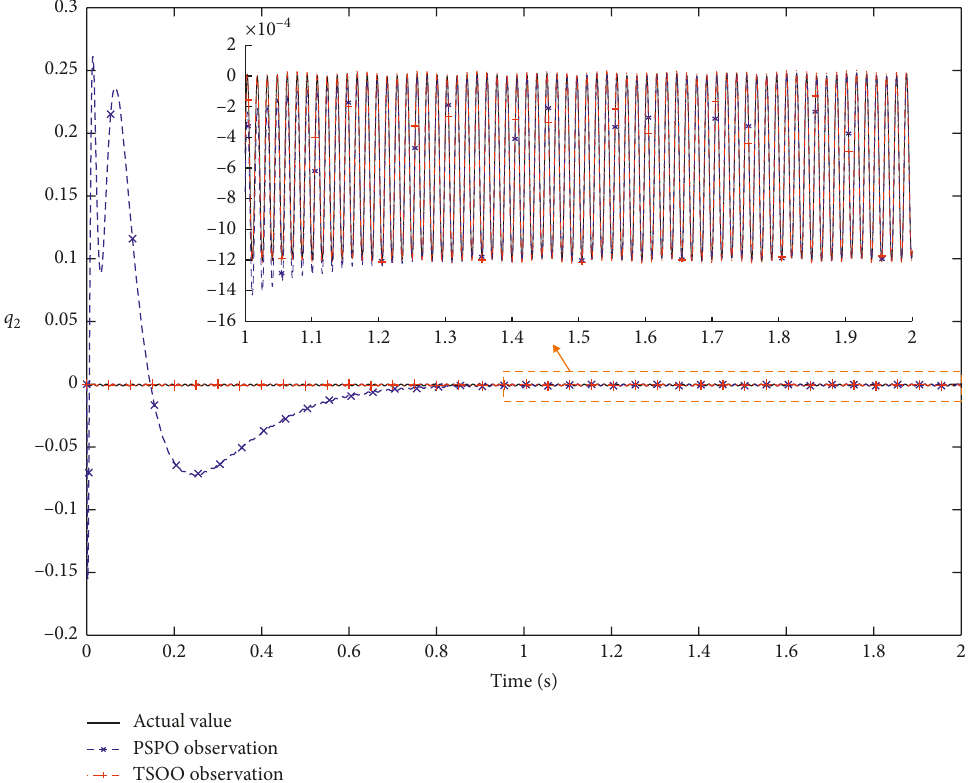
Figure 7: Observation effect comparison for the second-order mode coordinate.